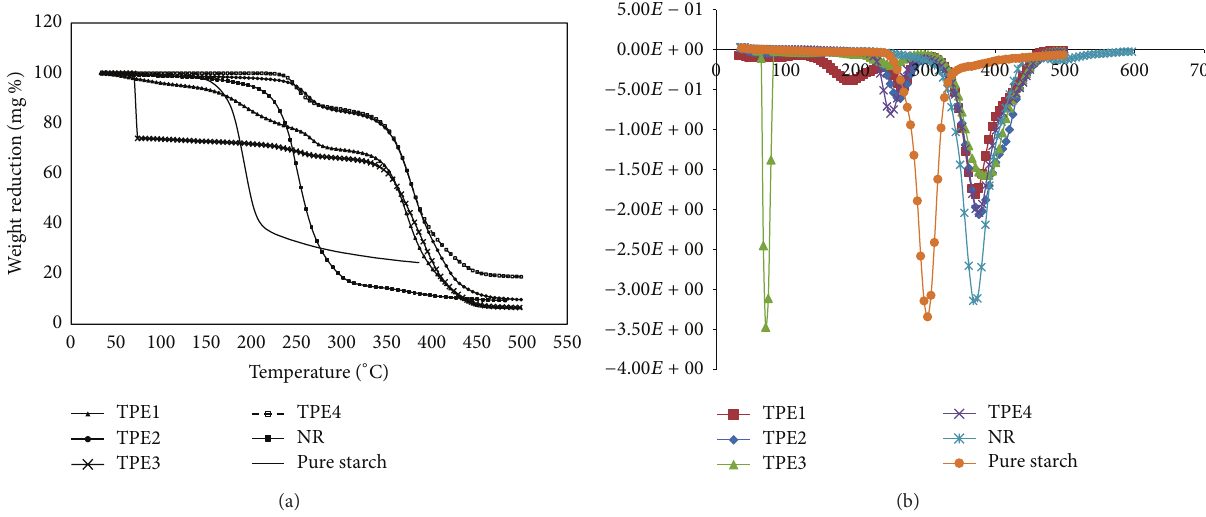
Figure 3: (a) Thermogravimetric analysis of TPE1, TPE2, TPE3, TPE4, natural rubber (NR), and pure starch. (b) Derivative thermogravi- metric analysis of TPE1, TPE2, TPE3, TPE4, natural rubber (NR), and pure